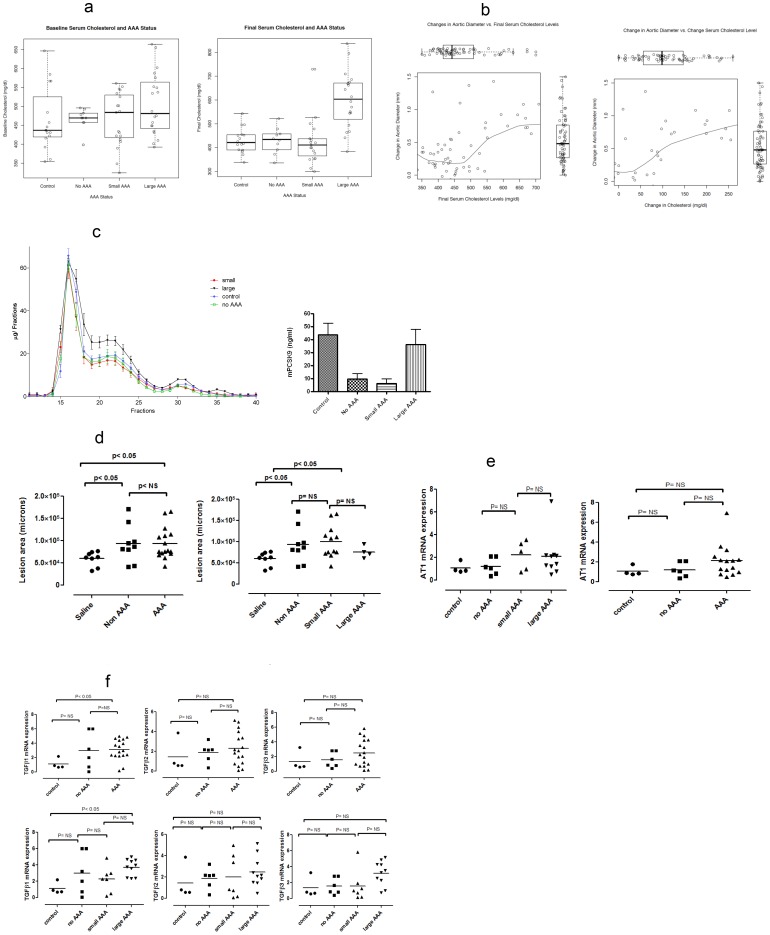
Relationships between total cholesterol, serum lipoproteins and atherosclerosis and AAA.(A) Relationship between total cholesterol concentration (TC) and change (delta) in aortic diameter. Left) Analysis of baseline serum cholesterol of 65 mice revealed no difference in cholesterol levels prior to treatment (control n = 16, no AAA n = 10, small AAA n = 19, and large AAA n = 20; p = 0.25). Right) Final total cholesterol levels, after 4 weeks infusion treatment, prior to sacrifice, revealed statistically significant increased levels of TC in mice that developed large AAA (control n = 16, no AAA n = 10, small AAA n = 19, large AAA n = 20, p<0.0001). (B) Graphical evaluation of both change in aortic diameter versus final cholesterol levels (left), and change in aortic diameter versus change in cholesterol levels (right) reveal clear first order trends suggested by the nonparametric smoothing lines. The separate distribution of each variable is captured the box plot insert opposite its axis. Formal evaluation by regression modeling indicates that both AngII exposure and final cholesterol levels are predictive of change in aortic diameter whereas baseline cholesterol level was not. (C) Serum lipoprotein analysis and PCSK9 serum levels. Left: FPLC analysis of cholesterol profile of each group of mice (control n = 16, no AAA n = 10, small AAA n = 19, large AAA n = 20). There was a statistically significant difference between large AAA and the other groups for LDL (fractions 20–25) (p<0.05). Right: PCSK9 serum levels are significantly reduced by AngII exposure (no AAA and small AAA) except in mice with large AAA, where PCSK9 levels are similar to those of controls (control n = 16, no AAA n = 10, small AAA n = 19, and large AAA n = 20; p = 0.0019). (D) Atherosclerosis and AAA. Left: Mice treated with Ang II demonstrate significant increase in the extent of atherosclerosis in the aortic arch (control n = 8, no AAA n = 9, small AAA n = 12 and large n = 4 p<0.05). No difference was seen between mice that developed AAA and those that did not. Right: Analysis of small and large AAA showed no differences in plaque formation. (E) AT1 expression and AAA. The differences in AT1 expression according Ang II exposure, AAA occurrence, or AAA size were not statistically significant (control n = 4, no AAA n = 6, small AAA n = 5 and large AAA n = 10). (F) TGFß and AAA. Comparison of differences in the expression of TGFβ 1, 2, and 3 between mice with and without AAA, and by AAA size, was statistically significant for TGFβ 1 when controls and AAA were compared (control n = 4, no AAA n = 6, small AAA n = 7 and large AAA n = 10; p<0.05). Analysis of TGFβ1 expression in AAA was significant only for the large AAA versus control.